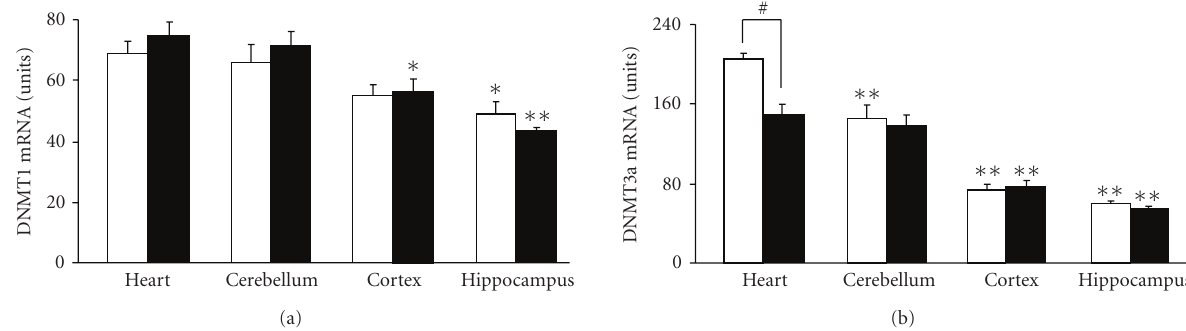
Figure 5: DNMT1 (a) and DNMT3a (b) mRNA levels in heart and brain tissues of young and old mice. The content of DNMT1/DNMT3a mRNA in the tissues of young and old mice was measured by real-time PCR. The results were normalized against the corresponding cyclophilin mRNA contents and are presented as units (the coe ffi cient of variation values amplified by a factor of 1000, see text for details). Data are expressed as mean ± S.E.M ( n = 5 − 10). Note that the only aging-associated di ff erence was observed for DNMT3a mRNA content in the heart ( # P < . 01, t -test). The content of DNMT mRNA was generally greater in the heart compared to the brain; ∗ P < . 05 and ∗ P < . 001 versus the corresponding values in the heart in the same age group (Dunnett’s